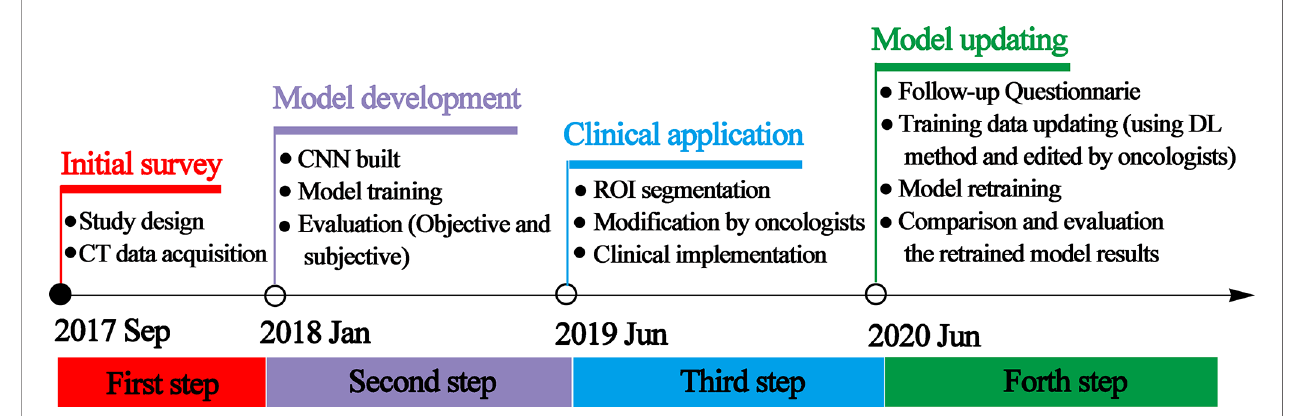
FIGURE 1 | Schematic of the study design representing the timeline and the details of